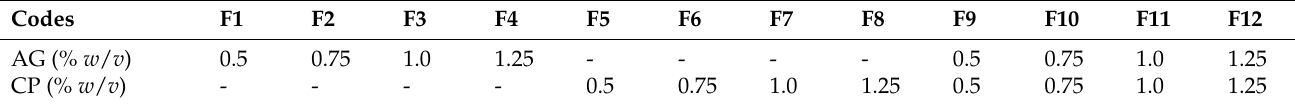
Table 1. Concentration of polymers added in the mucoadhesive smart